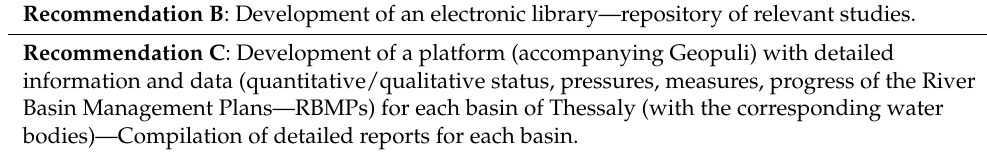
Table 2. The summary list of policy recommendations, with brief